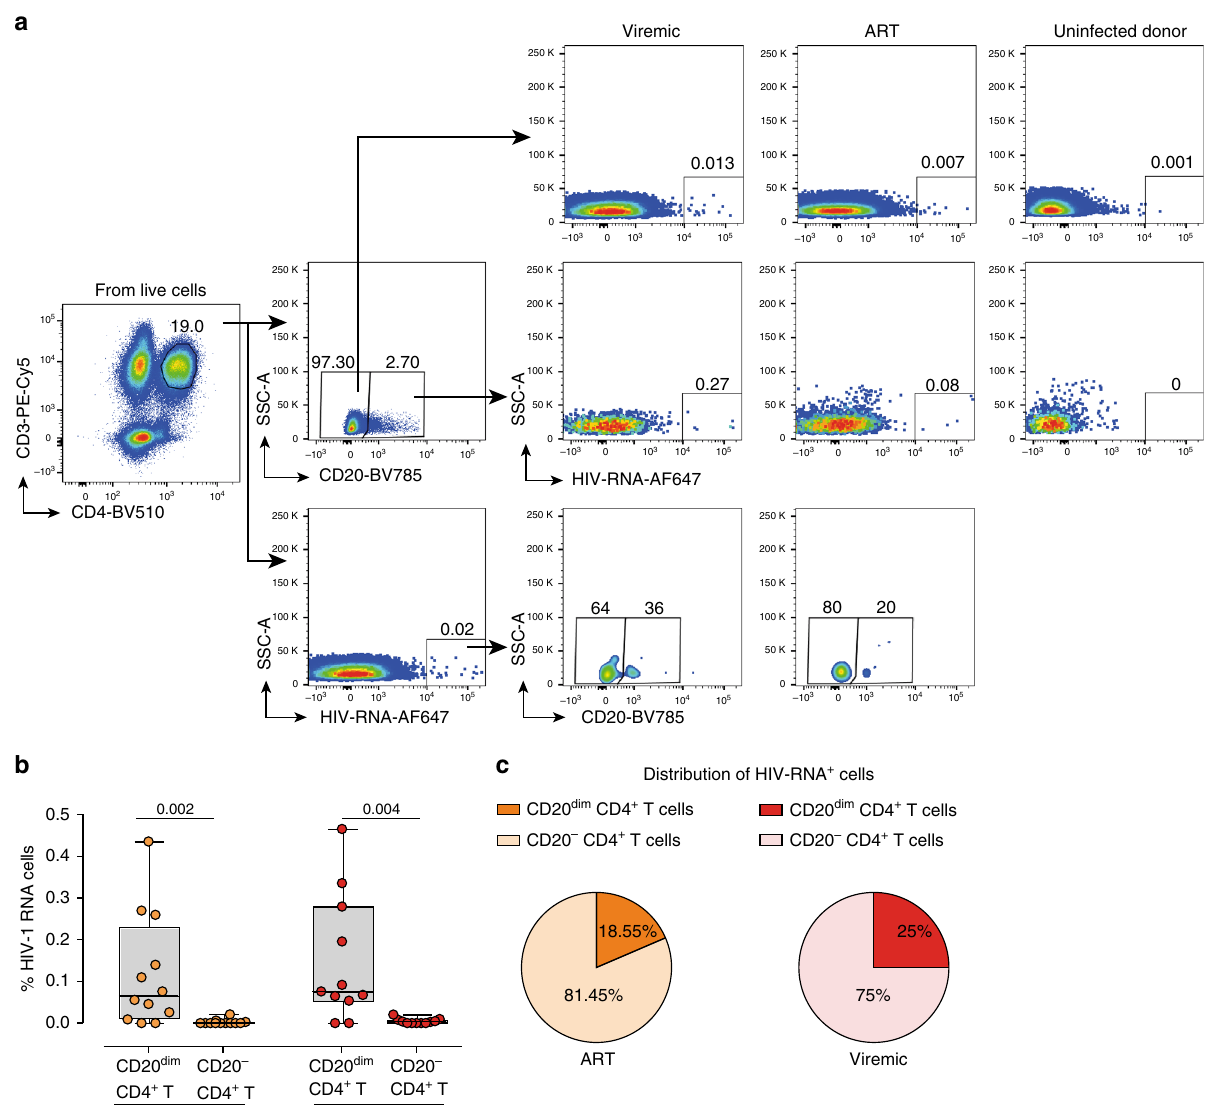
Fig. 2 CD20 dim CD4 + T cells are enriched in HIV-1 RNA. Unstimulated PBMCs were subjected to the RNA FISH- fl ow protocol to detect HIV RNA expression in CD20 dim CD4 + T cells. a Gating strategy used to determine the HIV RNA expression on CD20 − and CD20 dim CD4 + T cells and expression of CD20 in HIV RNA + cells. Previous sequential gates are represented in Supplementary Fig. 9. b Frequency comparison of HIV RNA + cells in CD20 dim CD4 + T cells and CD20 − CD4 + T cells of ART-suppressed and viremic patients. Wilcoxon test was used. c Mean distribution of HIV RNA + cells in the CD20 + and CD20 − phenotypes. Median values and min and max ranks are represented in panels ( b ) and ( c ). In all panels, n = 12 ART-suppressed and n = 11 viremic patients are shown. Data from patients #15 – 26, 60, 63, and 73 – 81 are included. Data underlying this Figure are provided as Source Data fi